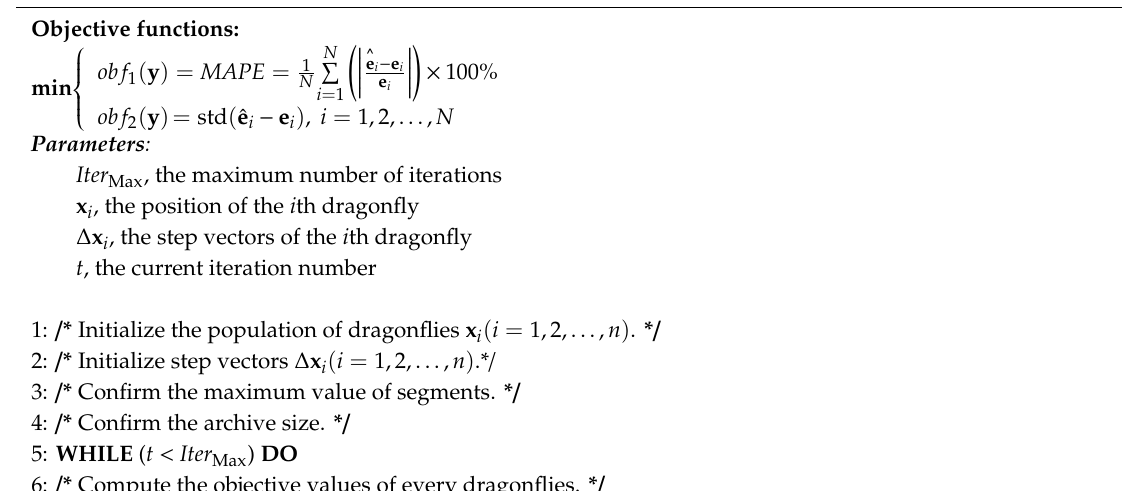
Algorithm 1: Multi-Objective Dragonfly Algorithm